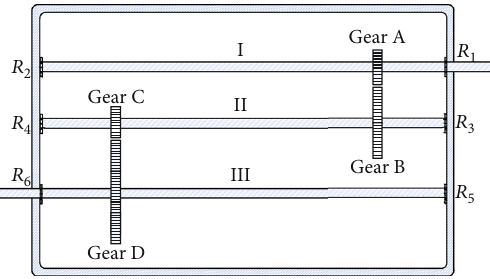
Figure 6: Structure diagram of the tested gearbox.